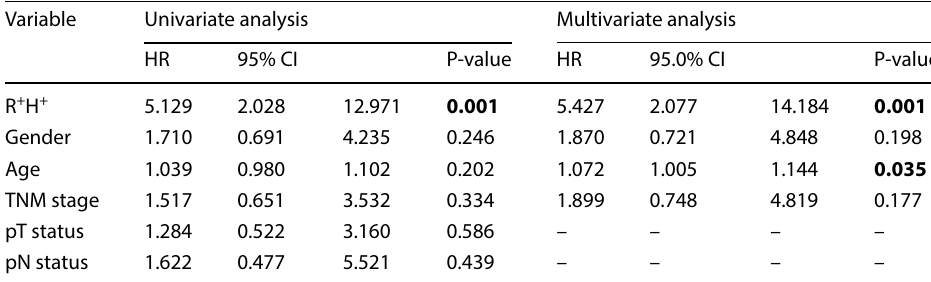
Table 6 Univariate and multivariate Cox proportional hazards models for combined expression of RUVBL1 and HNRNPU mRNAs (n = 455)